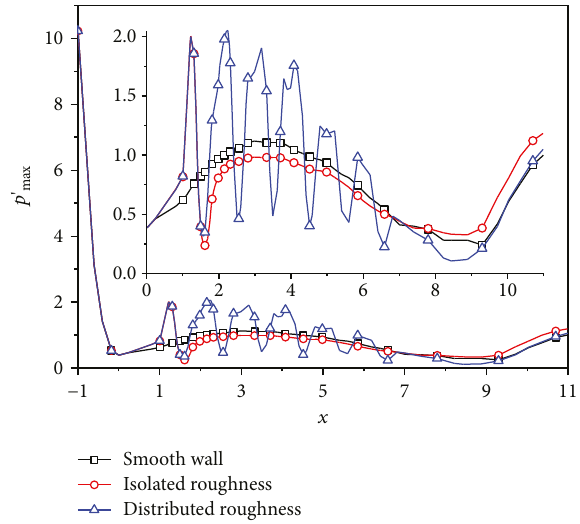
Figure 9: The distribution of maximum pressure disturbances along the fl ow